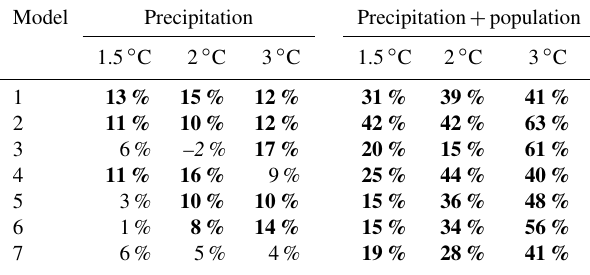
Table 5. Change in the probability of a damaging event in Cat- alonia for the 70th damage percentile and the three warming pe- riods with the mean 24h precipitation as explanatory variable (left) and mean 24h precipitation and population (SSP5) as explana- tory variables (right). The marked cells show statically significant ( p value < 0.05) increases (bold) and decreases (italic) in relation to the reference period